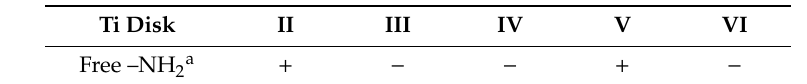
Table 1. Amino groups present in Ti disks.